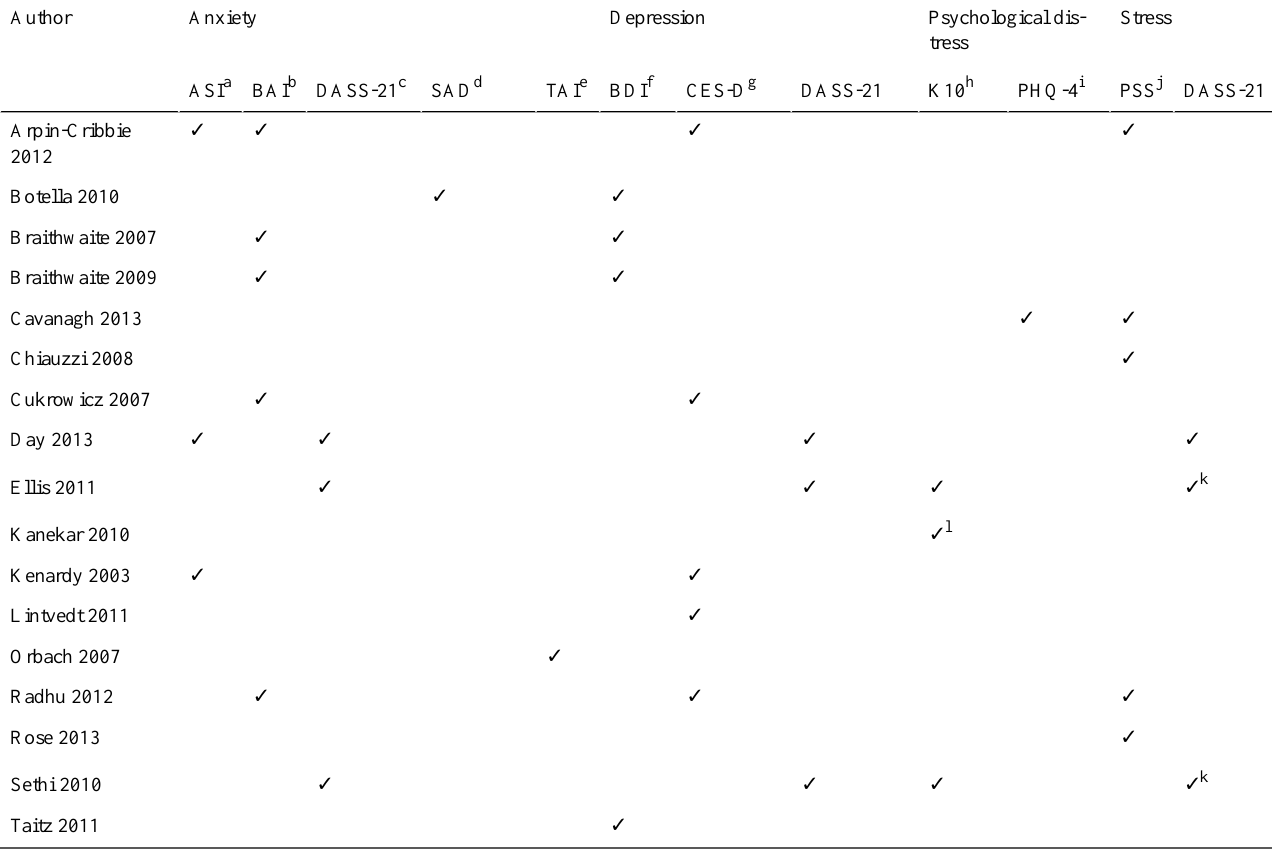
Table 1. Outcome measures used for assessment of depression, anxiety, psychological distress, and stress in the included studies.